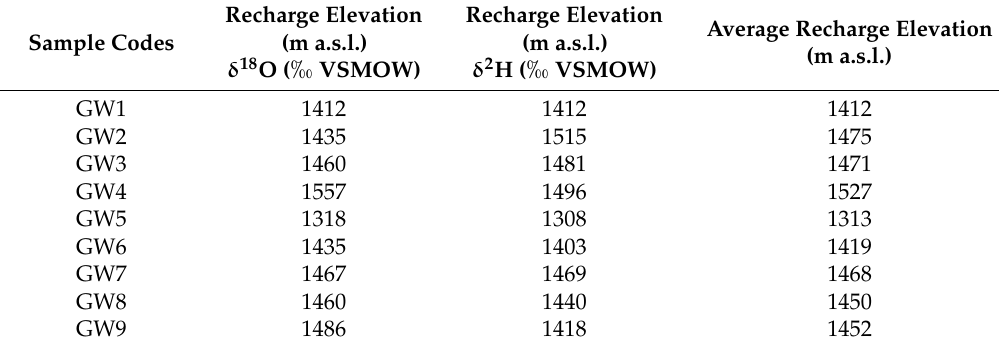
Table 6. Recharge elevation obtained by the application of the Arithmetic Average Method.